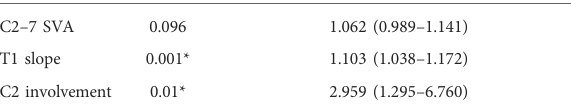
TABLE 7 Logistic regression of risk factors for ANP.